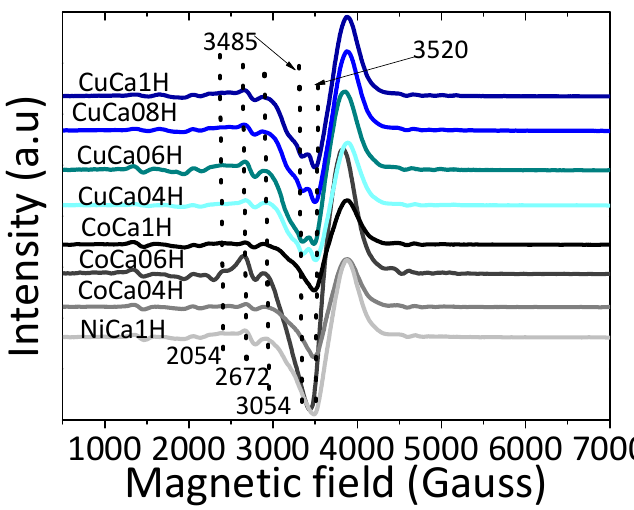
Figure 11. EPR spectra of the spent catalysts. The samples are evaluated in the EG reaction at 80 °C and glycerol to acetic acid molar ratio of 0.25.